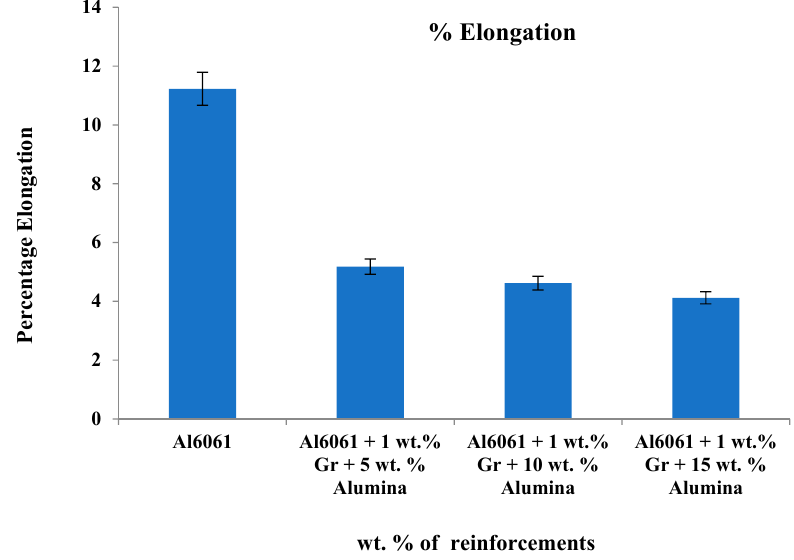
Figure 5. % Elongation variation in hybrid Al-Al 2 O 3 -graphene composites .